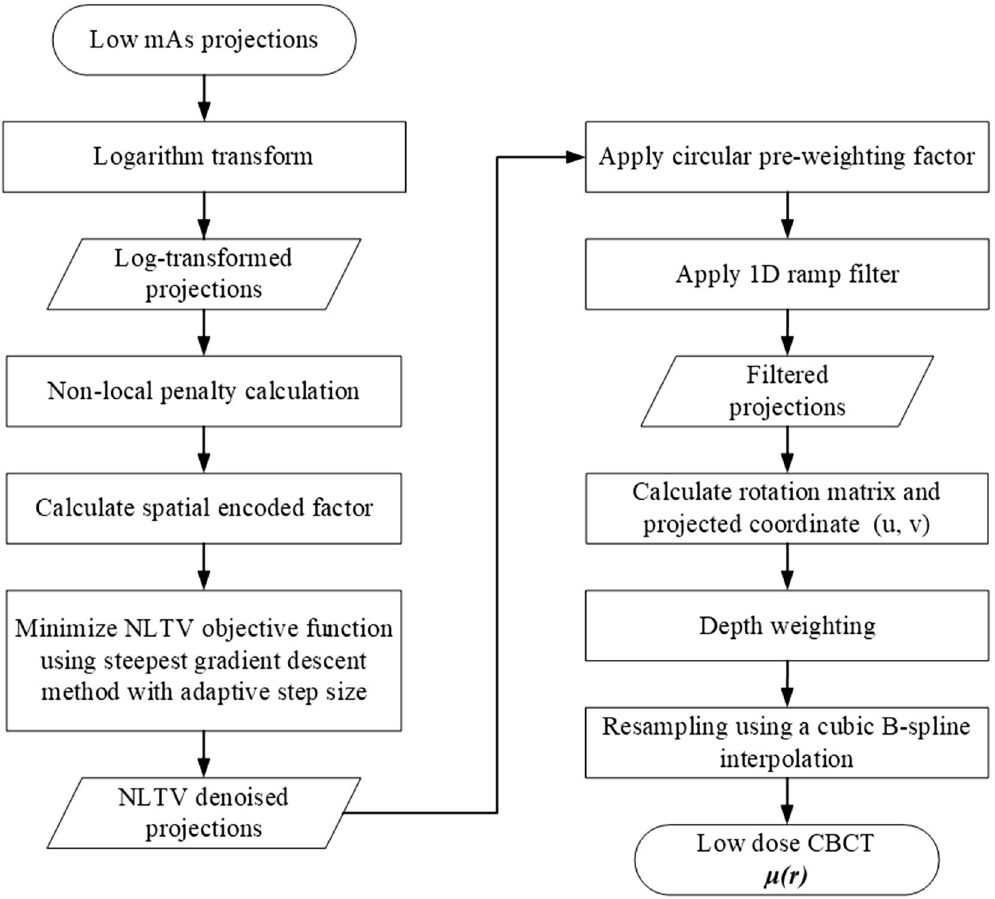
Figure 1. Overview of the proposed method for low-dose CBCT